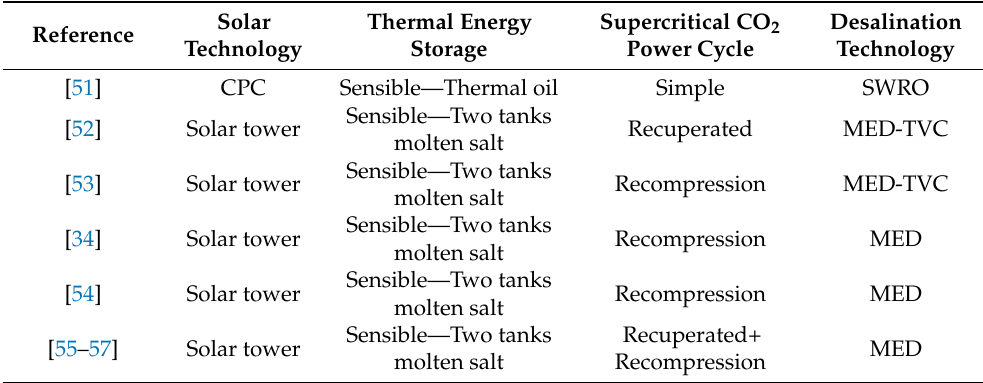
Table 1. Recent solar CO 2 -based power-cycle-driven desalination proposals.